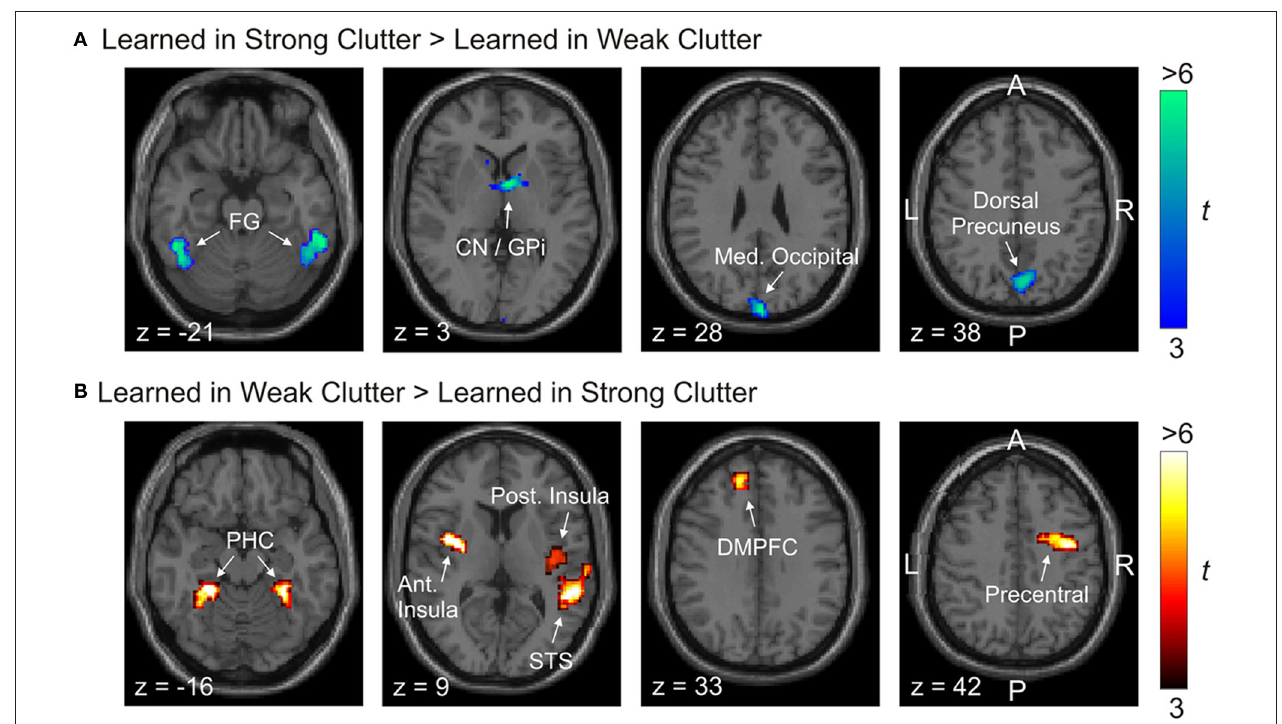
FIGURE 3 | Brain regions differentially responsive to visual objects learned with vs. without clutter. Activations are shown superimposed on axial slices of a standard individual brain template. (A) Regions more responsive to objects learned in strong clutter than to objects learned in weak clutter. (B) Regions more responsive to objects learned in weak clutter than to objects learned in strong clutter. BOLD responses to